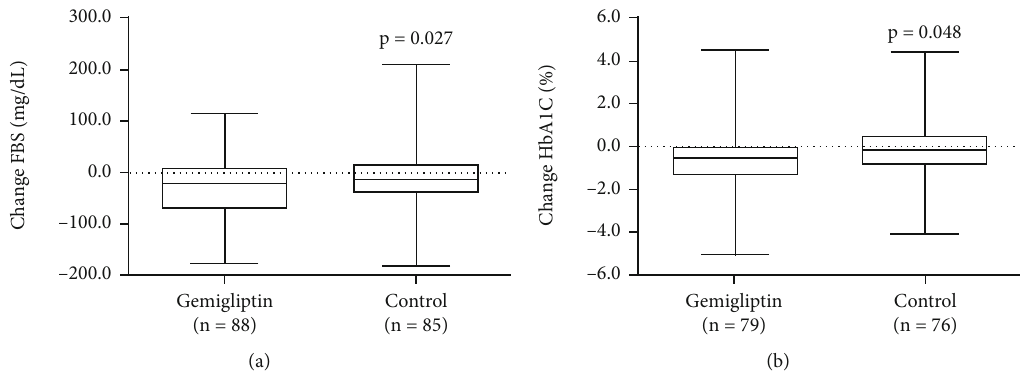
Figure 2: Box plot indicating changes in fasting blood sugar (a) and glycated hemoglobin (b) during the trial period. Data were set on the basis of scheduled visits.